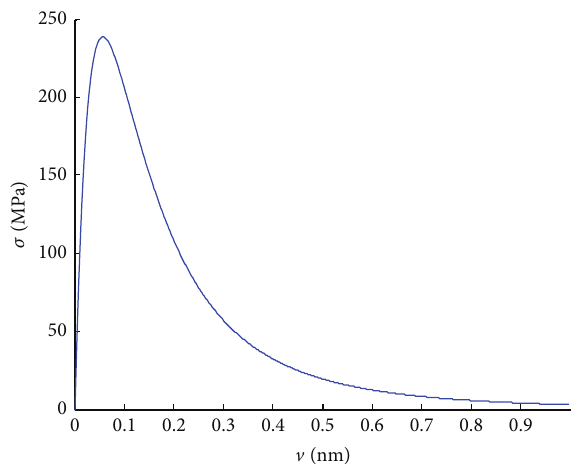
Figure 3: The relationship of normal stress and displacement based on van der Waals force.